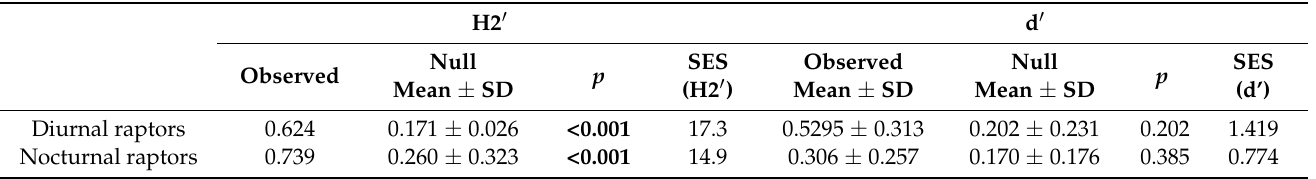
Table 2. Results of the observed and expected (null model predictions) network-level specialization (H2 (cid:48) ), haemosporidian lineage-level specialization (d (cid:48) ) indexes and standardized effect sizes (SES) of observed H2 (cid:48) and d (cid:48)